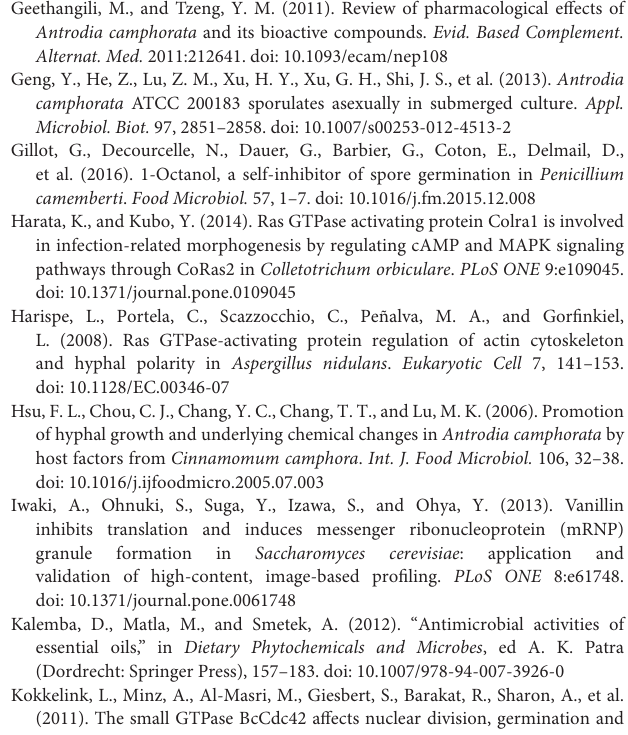
(Ko04510). Three proteins including Cdc42, Rac (Rac1), and PAK (PakA) were related to the germination of A. camphorata arthroconidia. Table S1 | Reported volatile compounds in C. kaehirae , C. camphora , and A. camphorata . Table S2 | Local database of germination-related proteins. Table S3 | Primers used for RT-qPCR. Table S4 | Proteins in A. camphorata arthroconidia identified by iTRAQ. Table S5 | Annotation of the proteins from iTRAQ with the GO database. Table S6 | Annotation of the proteins from iTRAQ with the KEGG database. Table S7 | Germination-related proteins in A. camphorata arthroconidia identified by